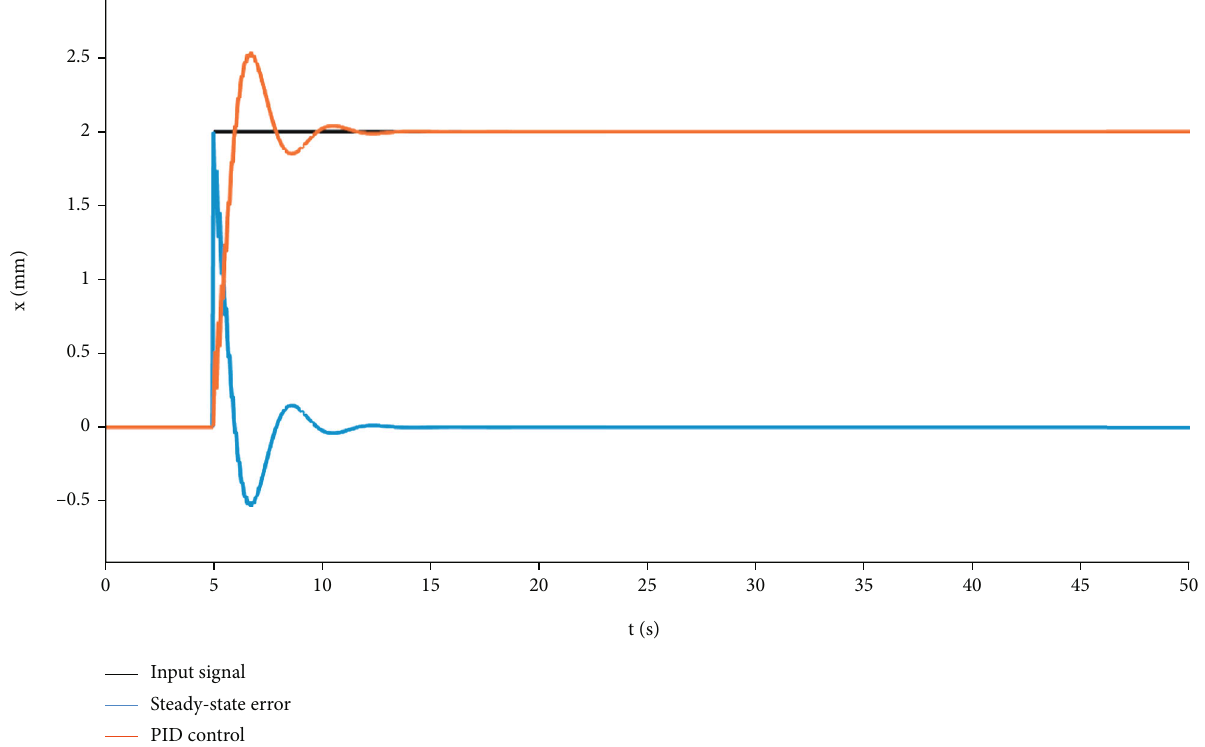
Figure 5: PID control tracking signal